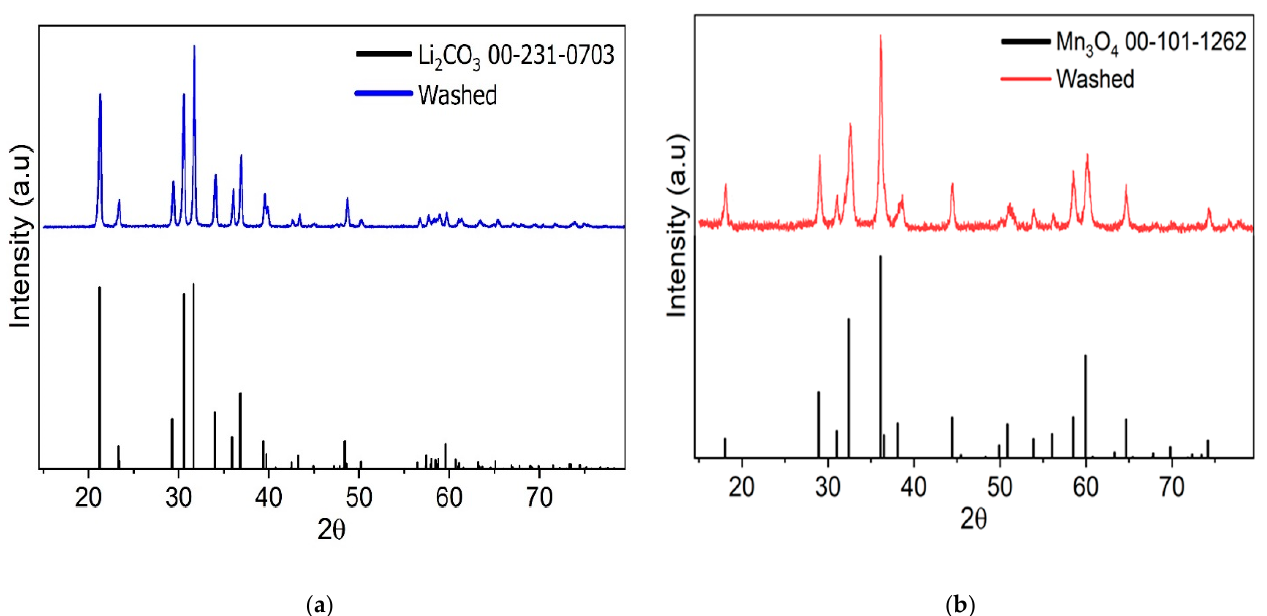
Figure 2. X-ray diffraction spectra of washed products: Li 2 CO 3 ( a ) and Mn hydroxides ( b ) after washing in filter press. washing in filter